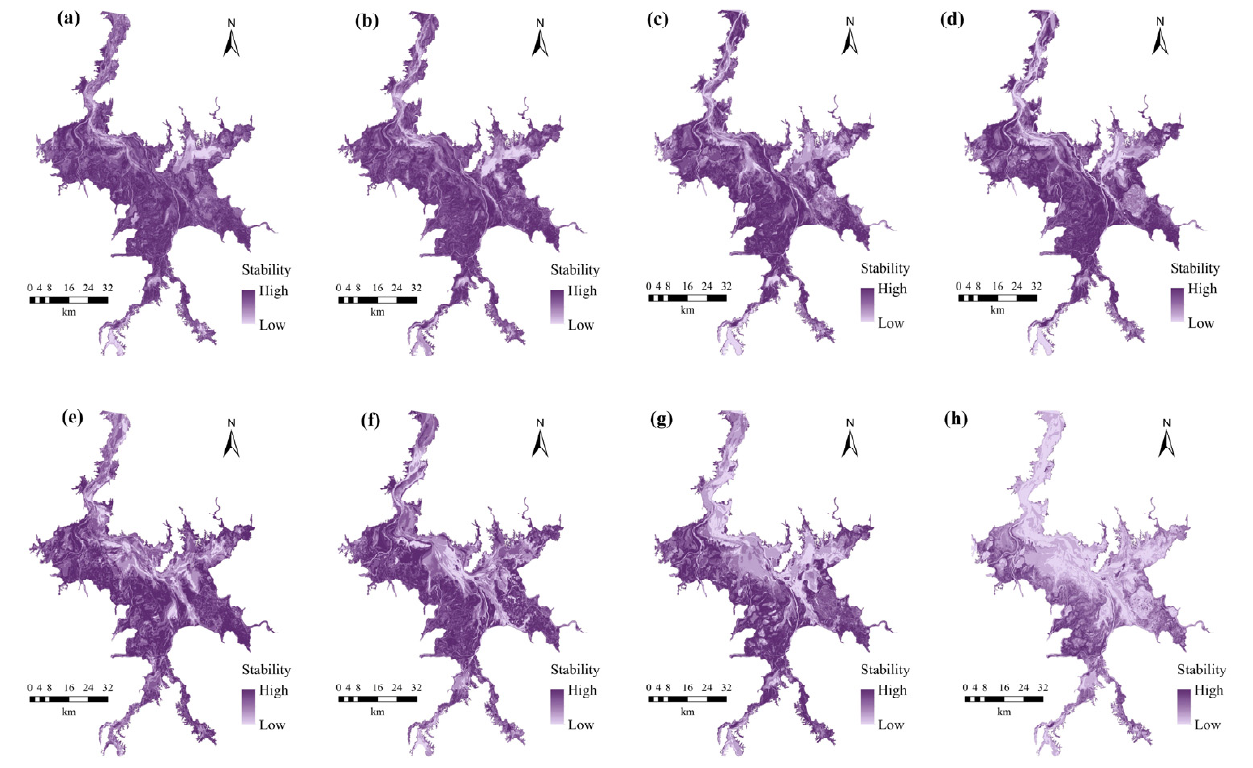
Figure 4. Stabilities of crane habitats within various water level intervals: ( a ) 5–6 m; ( b ) 6–7 m; ( c ) 7– 8 m; ( d ) 8–9 m; ( e ) 9–10 m; ( f ) 10–11 m; ( g ) 11–12 m; ( h ) 12–16 m.